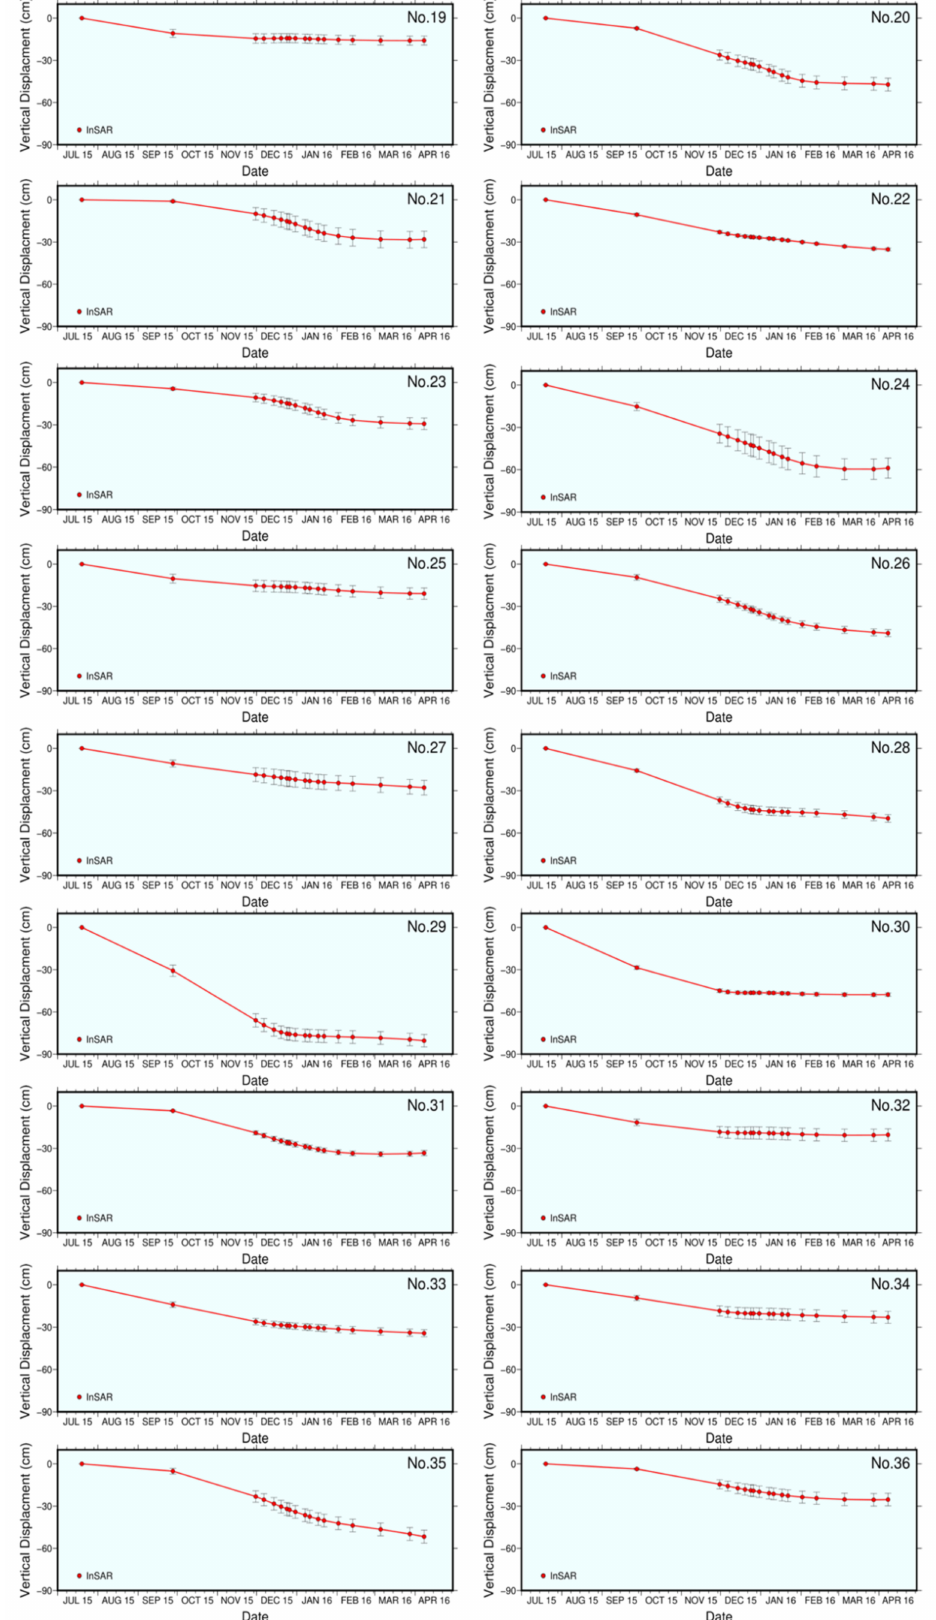
Figure A4. The subsidence time series of mining sites from No.19 to